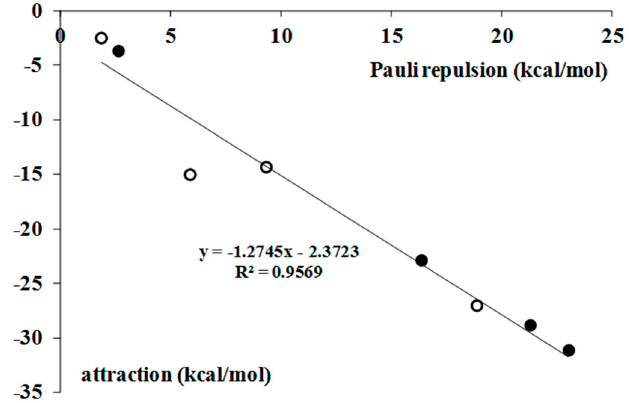
Figure 2. The linear correlation between the repulsion interaction energy and the sum of attractive terms (both in kcal/mol); black circles—the BrF 3 complexes, white circles—the BrF 5 complexes.